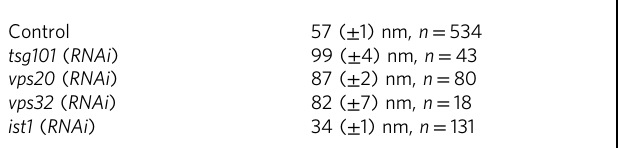
Table 2 Intralumenal vesicle (ILV) diameter statistics Control